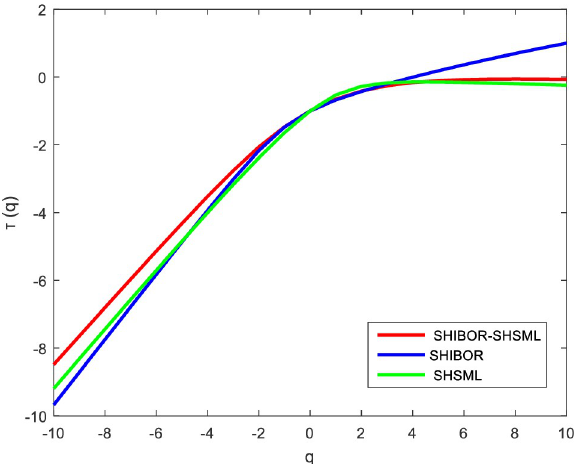
Fig 6. The Renyi exponent between SHIBOR and SHSML in the long